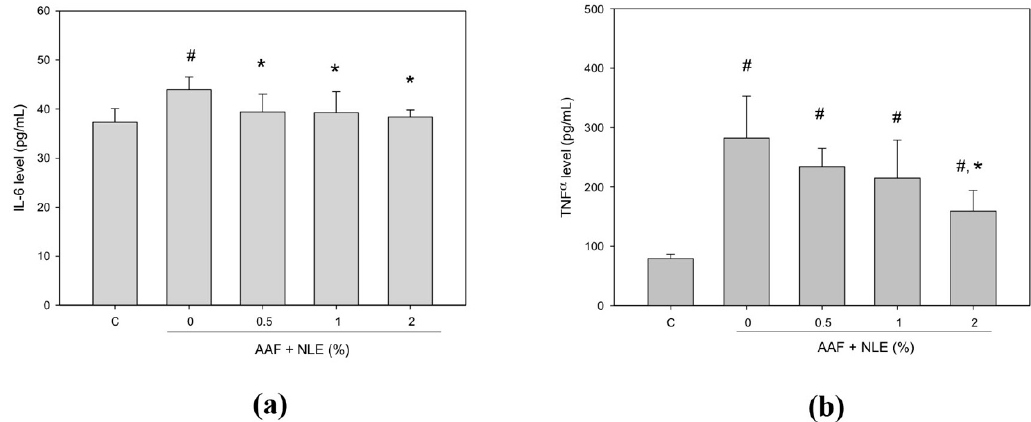
Figure 4. Effect of NLE supplementation on the inflammatory mediators induced by AAF in rats. The inflammatory factors interleukin (IL-6) ( a ) and tumor necrosis factor (TNF- α ) ( b ) levels were quantitated in the plasma from AAF-induced rats. Rats were fed a normal diet (as the C group), a normal diet containing AAF (as the AAF group), a normal diet containing AAF with 0.5% NLE (as the AAF + NLE 0.5% group), a normal diet containing AAF with 1% NLE (as the AAF + NLE 1% group), and a normal diet containing AAF with 2% NLE (as the AAF + NLE 2% group). Data are shown as means ± SDs; Results were statistically analyzed with ANOVA and significantly different was set as p < 0.05 according to Duncan’s multiple range test. # p < 0.05, compared with the control group, * p < 0.05 compared with the AAF group.